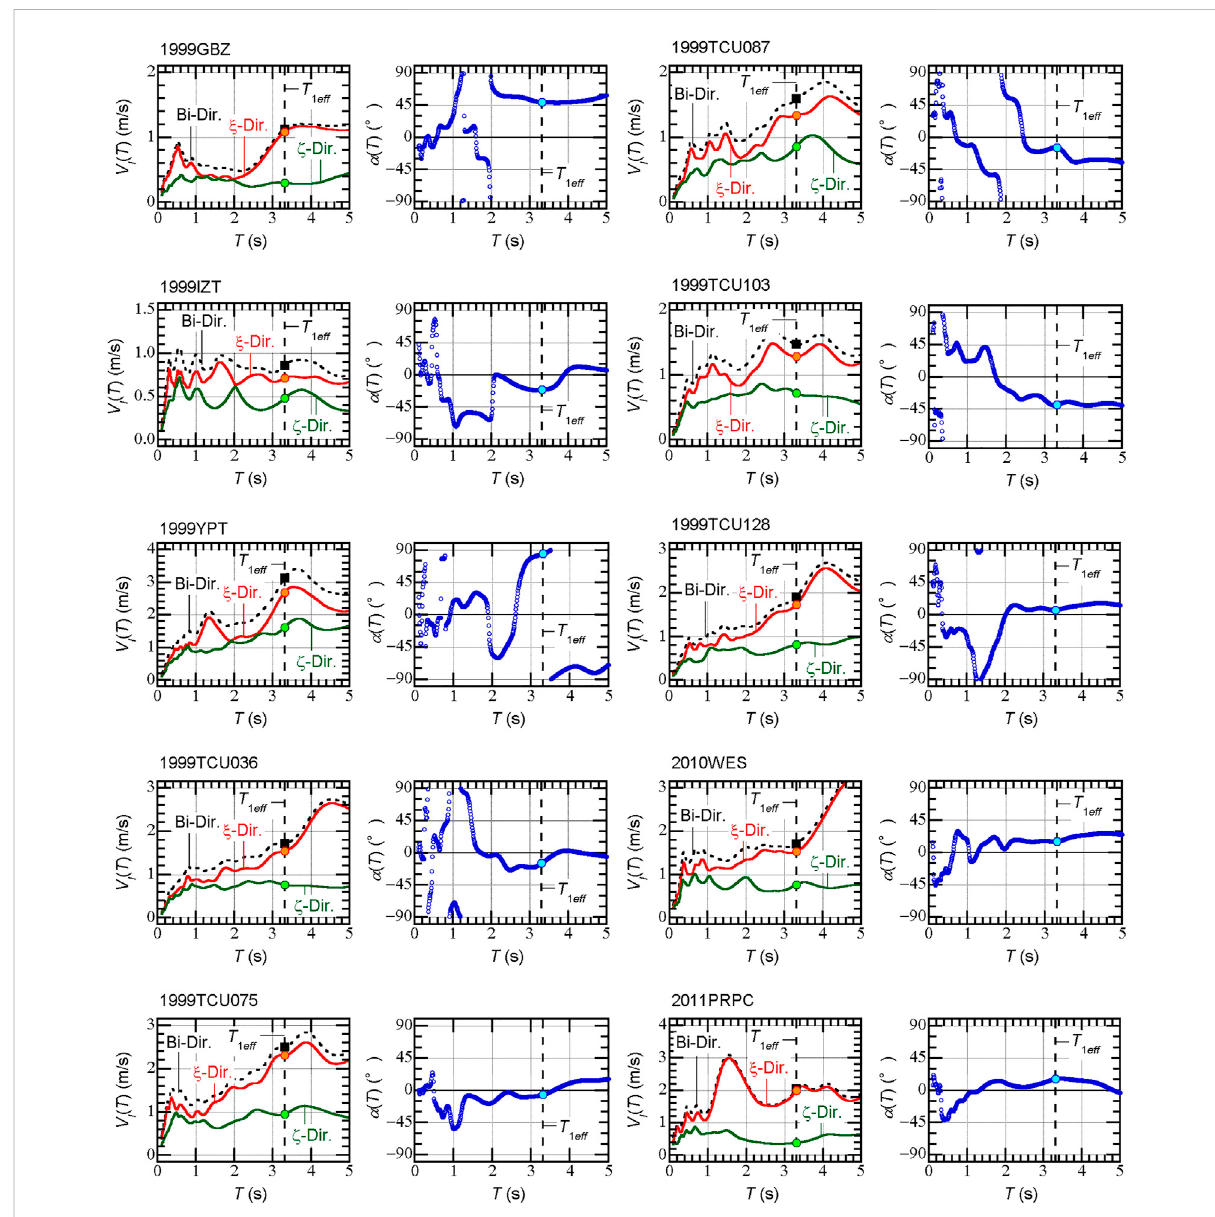
FIGURE 7 Total input energy spectra of the unscaled ground motion